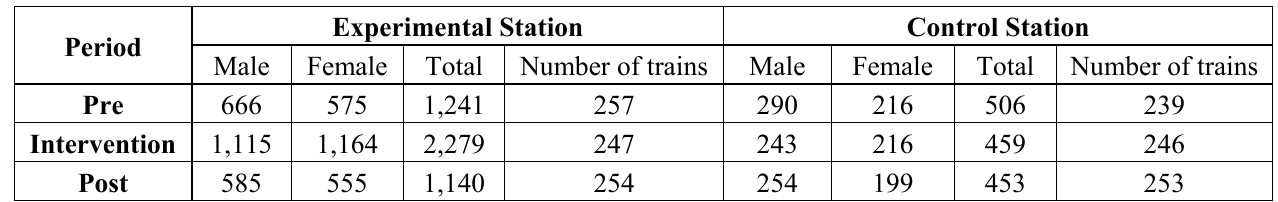
Table 1. Number of stair climbers and trains in the experimental and control stations at different